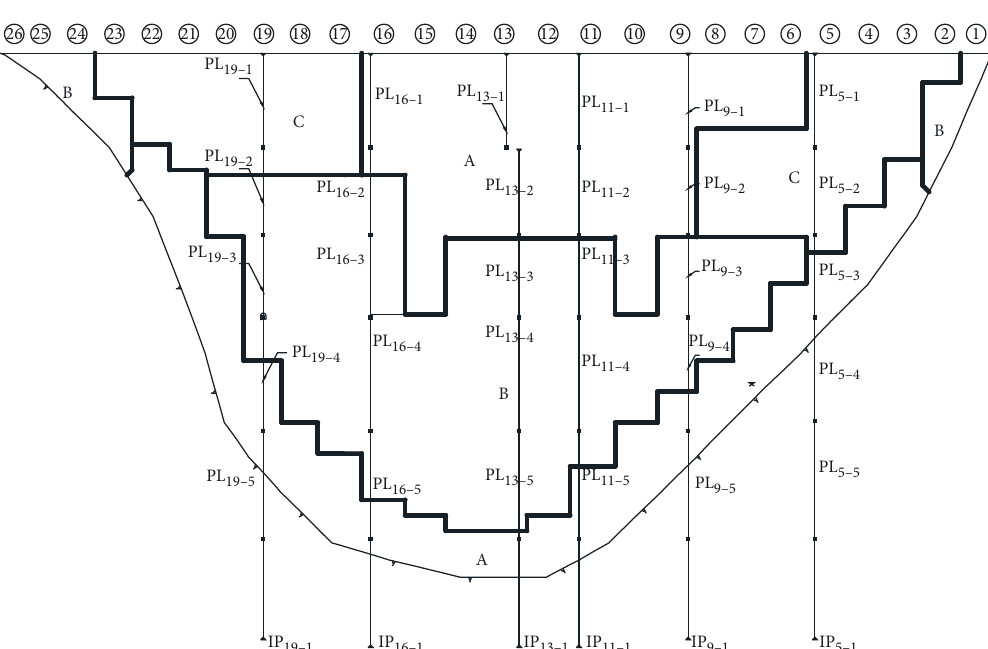
Figure 6: Distribution of the vertical-line measuring points and corresponding material partitioning.